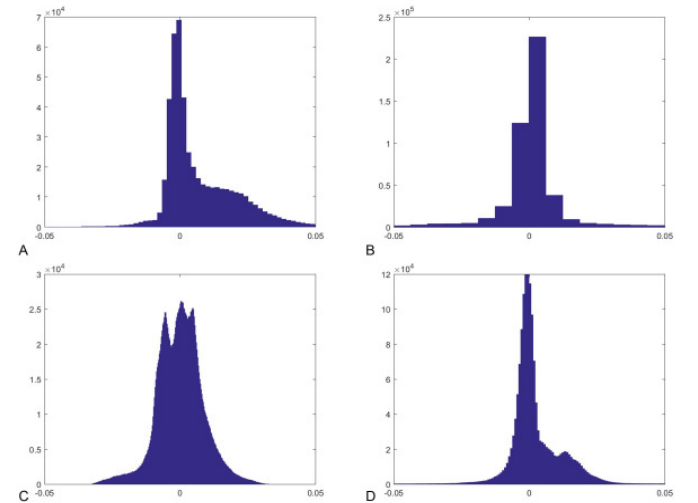
Figure 11. Histogram of MVS point deviations from a plane a) Xiaomi Yi 2k, b) Xiaomi Yi